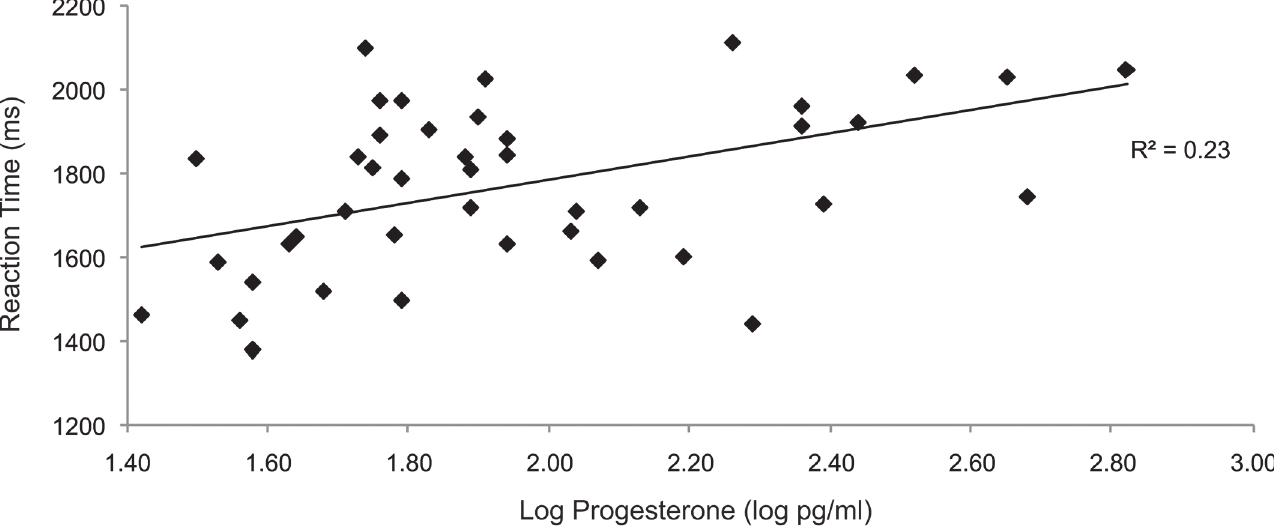
Fig 1. The association between reaction times across all emotions and progesterone (log) values. Line of best fit is shown along with R 2 indicating the degree of variance in recognition performance accounted for by progesterone.